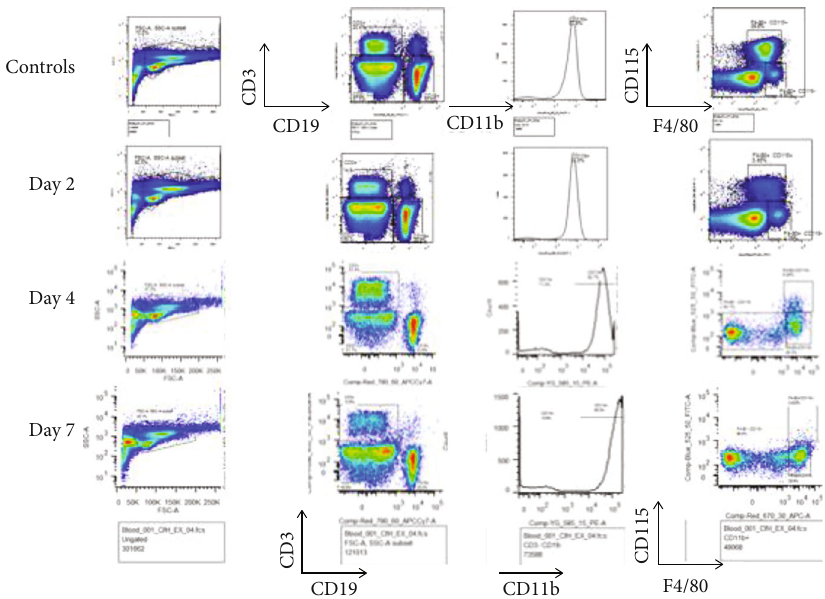
Figure 2: Clodronate increasingly reduces kidney macrophages in mice with FH-dependent ICGN. Given are the fl ow cytometry pro fi les of F4/80+ monocytes/M ϕ s on day 0, 2, 4, and 7, representatively. The expression of F4/80+ cells was determined by fl ow cytometry. Data were analyzed using FlowJo V10 software. F4/80+ cells are signi fi cantly reduced at each time point reaching less than 10% by day 7. Each time point n = 6